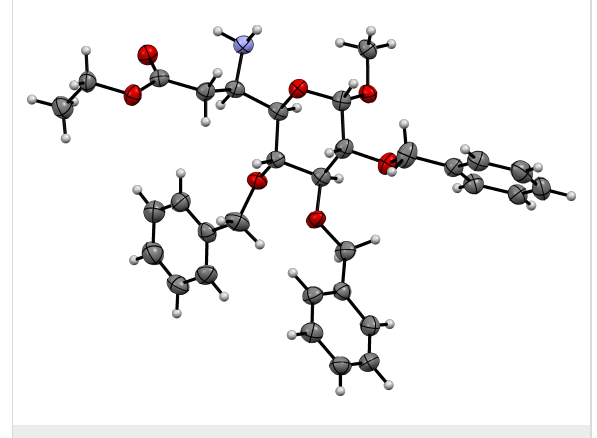
Figure 3: ORTEP diagram of compound 10b .